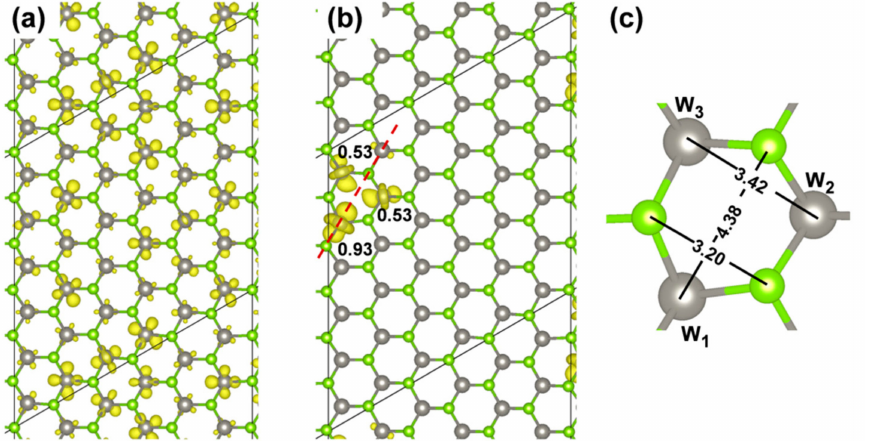
Figure 9. Spin density plots for the triplet state ( a ) before and ( b ) after geometry relaxation calculated by HSE06/CRY14 with a 6 × 6 supercell of WSe 2 ; ( c ) Geometry parameters (in Å) after the relaxation due to the exciton. The isosurface level is 0.0015 and 0.006 electron/bohr 3 for ( a ) and ( b ), respectively. Mulliken electron spin density values on W atoms are given in ( b